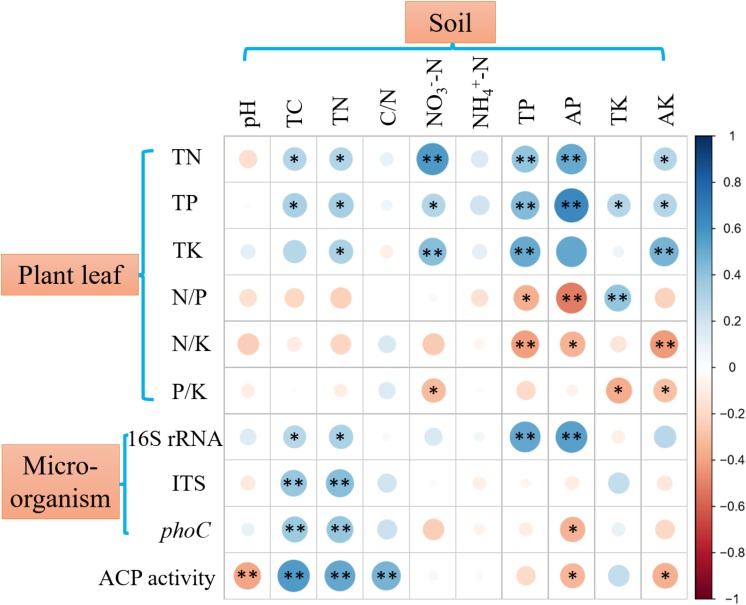
Spearman’s correlations between plant nutrients, microbial abundance, ACP activity and soil variables. 16S rRNA, 16S rRNA gene copy number; ITS, fungal ITS gene copy number; phoC, phoC gene copy number. ∗∗ Indicates significant correlations at p < 0.01; ∗ Indicates significant correlations at p < 0.05. Blue dots indicate positive correlations, and red dots indicate negative correlations.